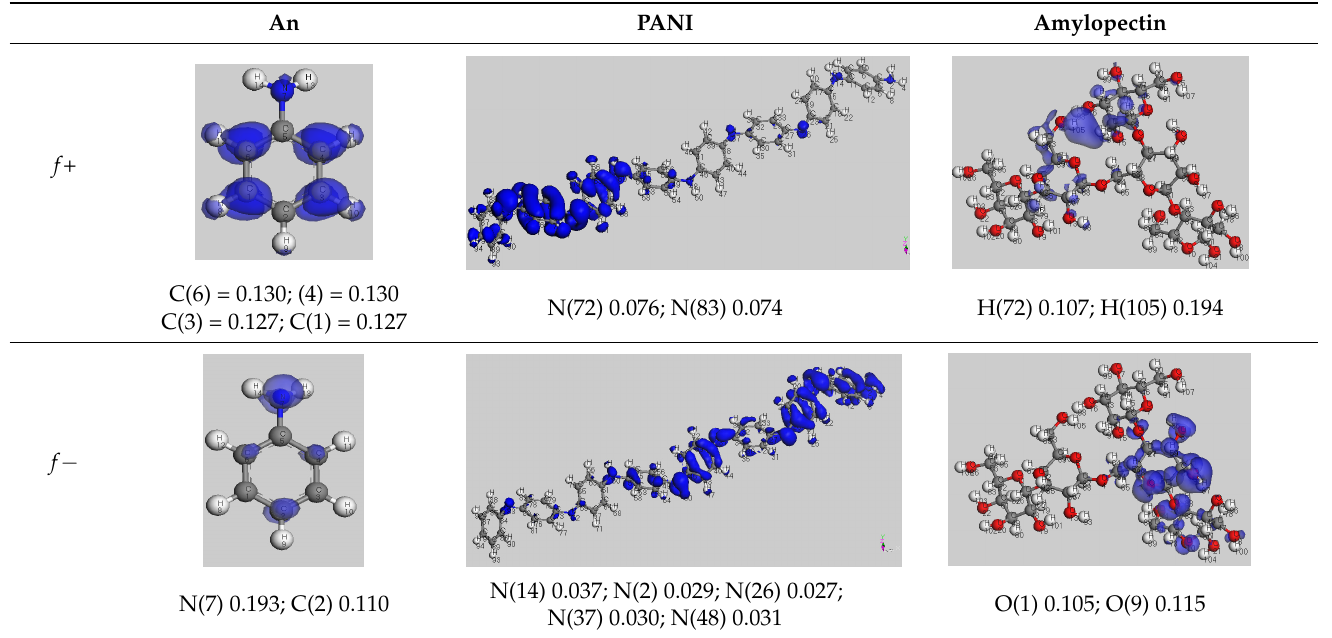
The Fukui results shown Table 11 led to the same conclusion as HOMO and LUMO.